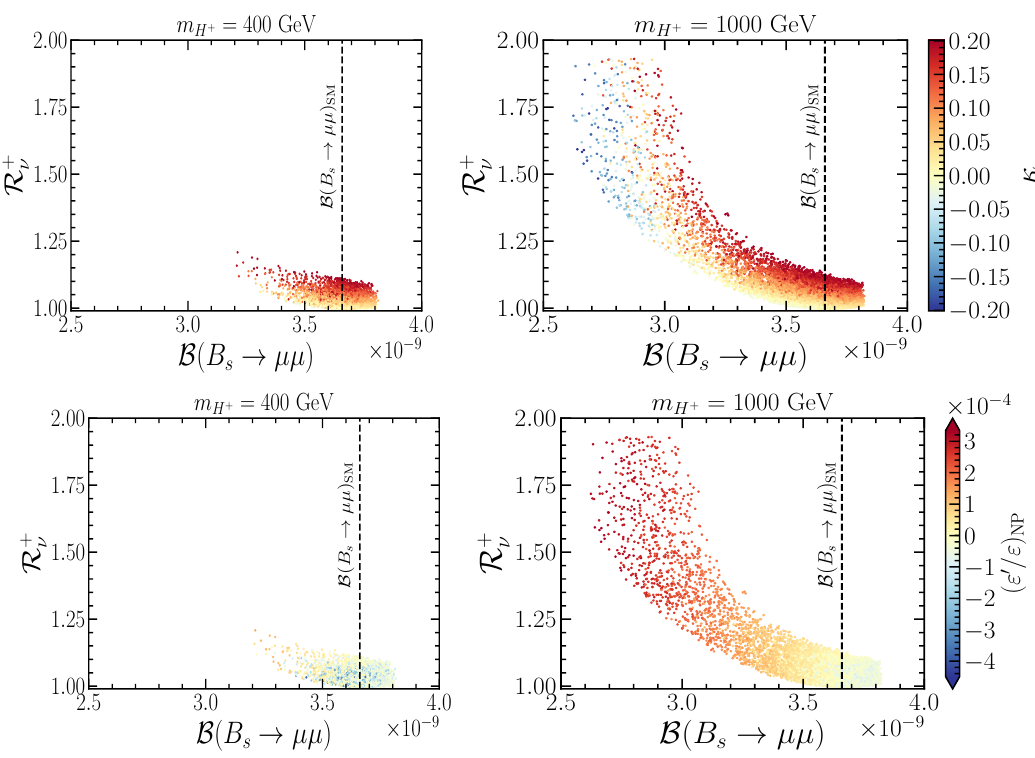
Figure 9 . Correlations between K + → π + ν ¯ ν , B s → µ + µ − , and κ (upper) and ( ε 0 /ε ) NP (lower). For the corresponding SM prediction, we find B ( B central value of which is shown as black dashed line in figure